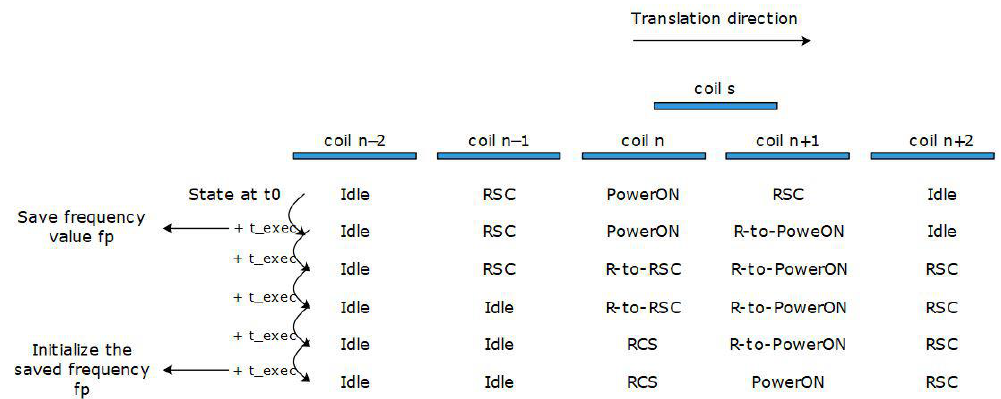
Figure 10. A step-by-step execution of a transition from coiln to coil n+1 .